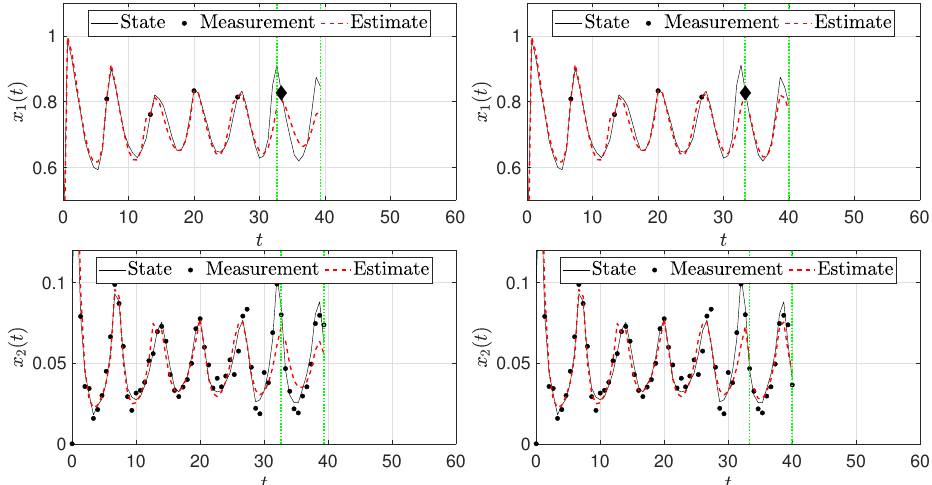
Figure 1. State estimation for exothermic reactor before ( left ) and after ( right ) slow conversion sensor measurement (black diamond) is available: Estimates of x 1 ( t ) and x 2 ( t ) improve in the delay window (between the green horizontal lines) if measurement of x 1 ( t ) becomes